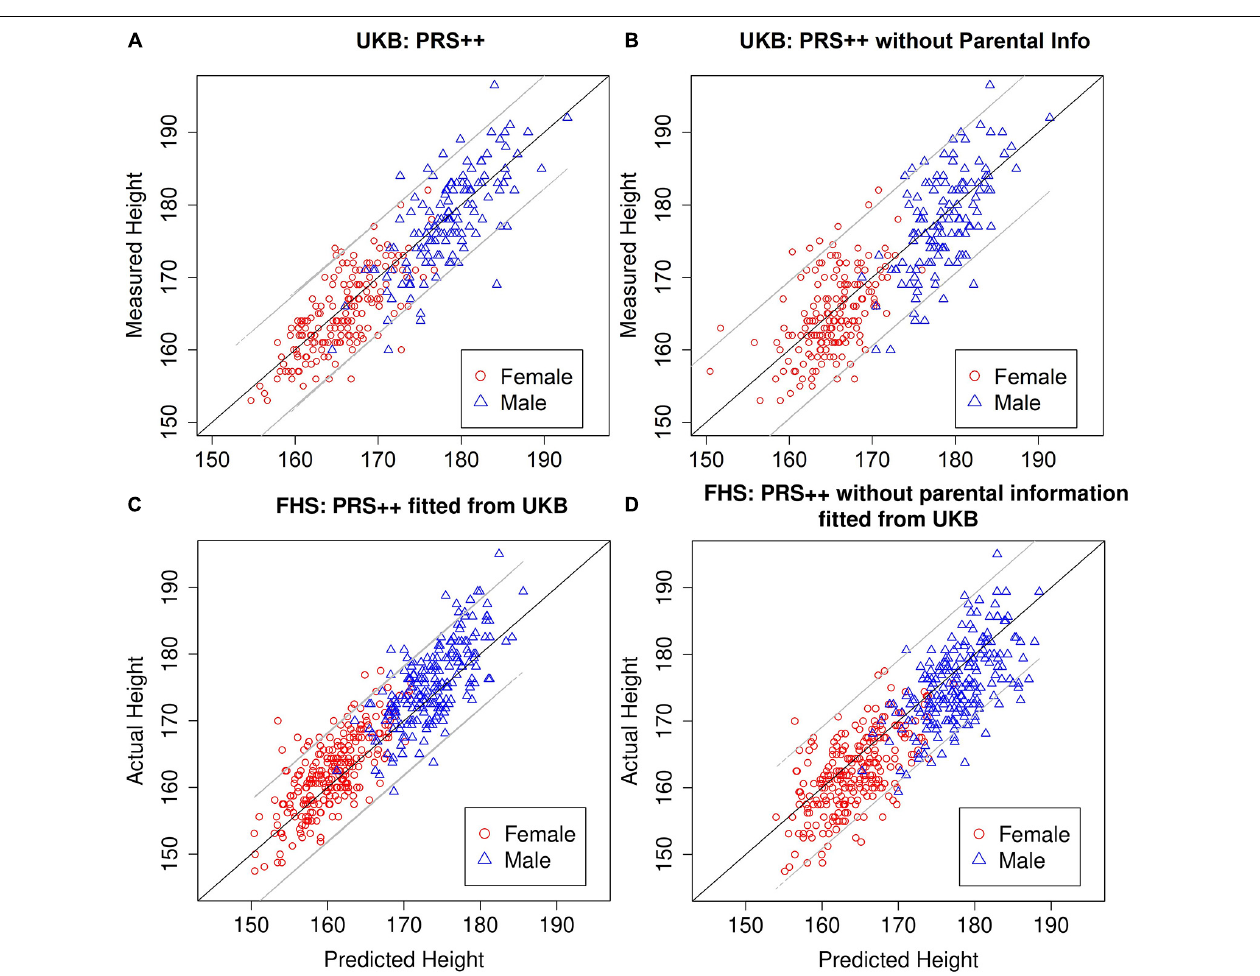
FIGURE 1 | Measured vs. predicted heights of probands. Based on 300 randomly selected individuals from the United Kingdom Biobank trio data not included in predictor training in the PRS ++ model (A) , the PRS ++ model without parental information (B) , FHS using the PRS ++ model fitted from United Kingdom Biobank data (C) , and FHS using the PRS ++ model without parental information fitted from United Kingdom Biobank data (D) . The gray lines represent a 95% prediction interval.